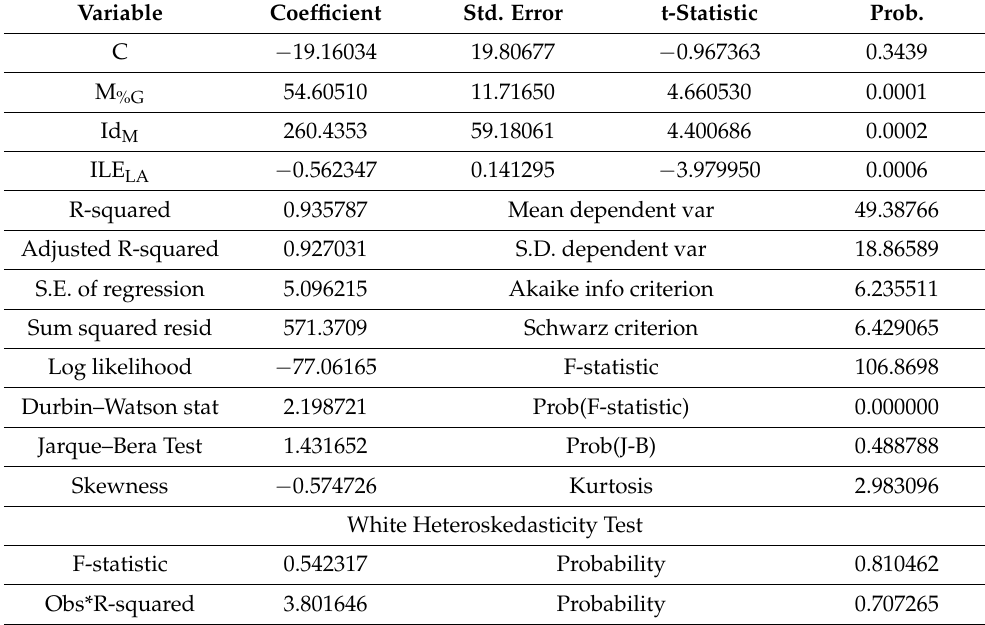
Table 3. S FDI_in(%GDP) model by M %G , Id M and ILE LA for